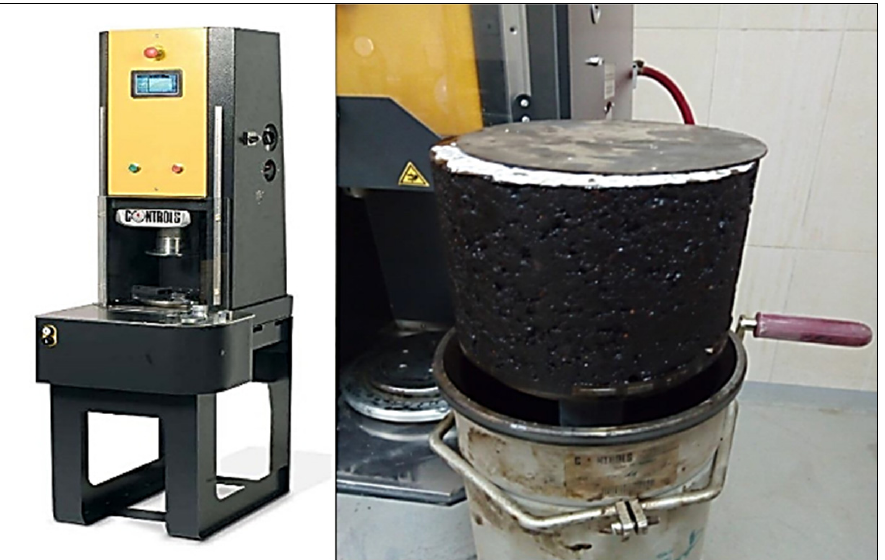
Figure 4. Asphalt sample compacted using SGC.